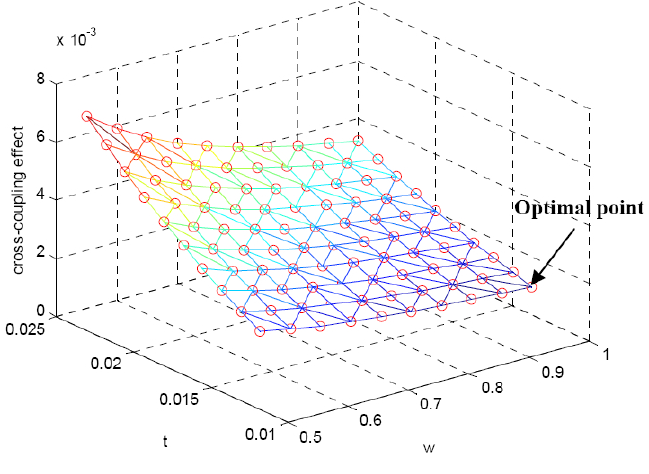
Figure 7. Cross-coupling e ff ect.